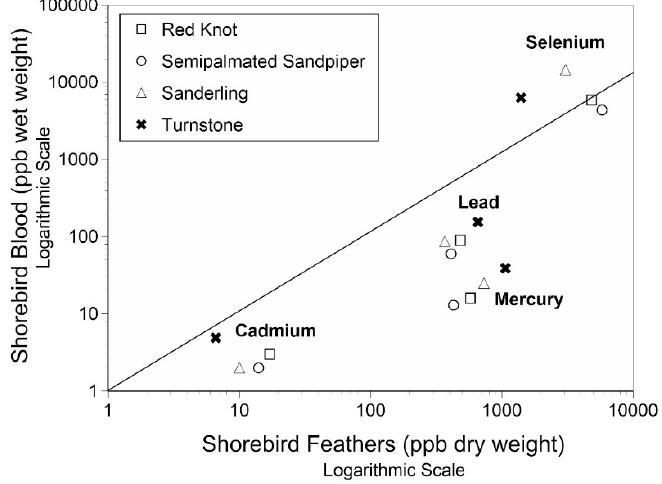
Figure 4. Relationship between levels of metals in the feathers and blood of four species of shorebird.